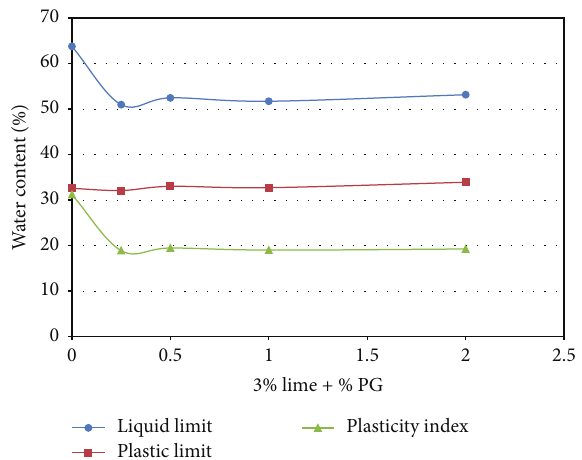
Figure 3: Effect of PG on the plasticity of 3% lime stabilized